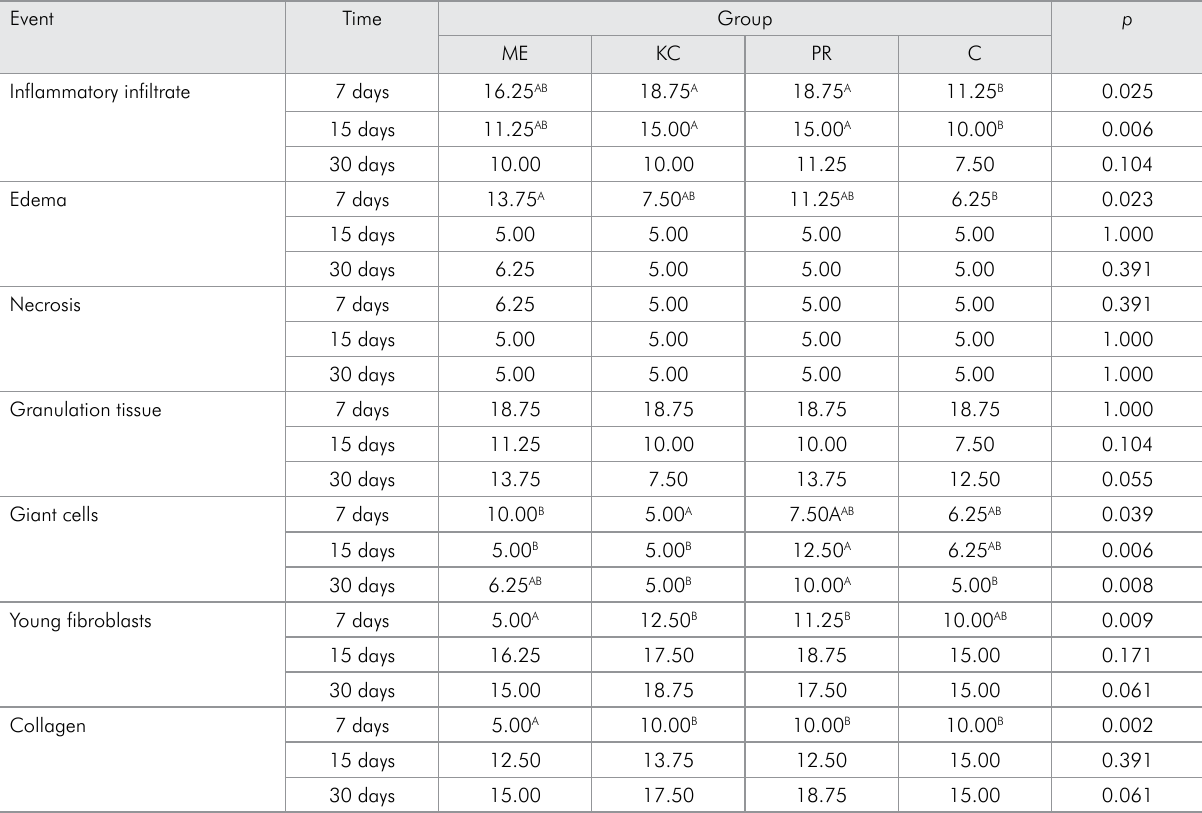
table 2. Mean scores attributed to cements and control group, after time intervals of 7, 15 and 30 days, for the 7 events evaluated. Event Time